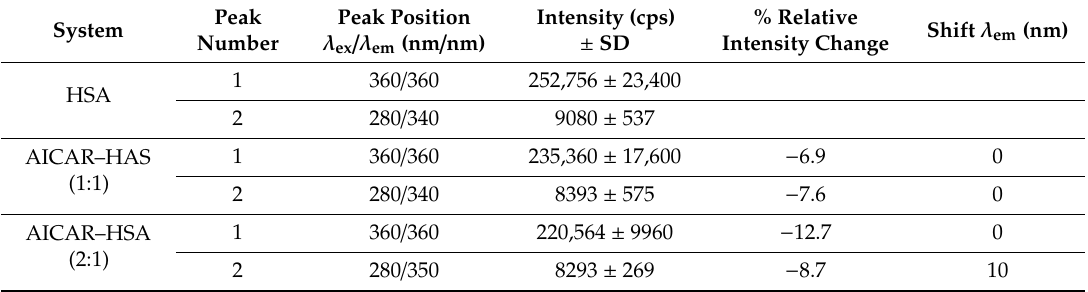
Figure 5. The 3D fluorescence contour map of free HSA (5 µ M) ( A ) and the bound AICAR–HSA complex after addition of AICAR (5 µ M) ( C ). The 3D fluorescence projections of free HSA (5 µ M) ( B ) and bound AICAR–HSA complex after addition of AICAR (10 µ M) ( D ). Table 5. 3D fluorescence spectroscopy data for HSA / AICAR in ratios of 1 / 1 and 1 /